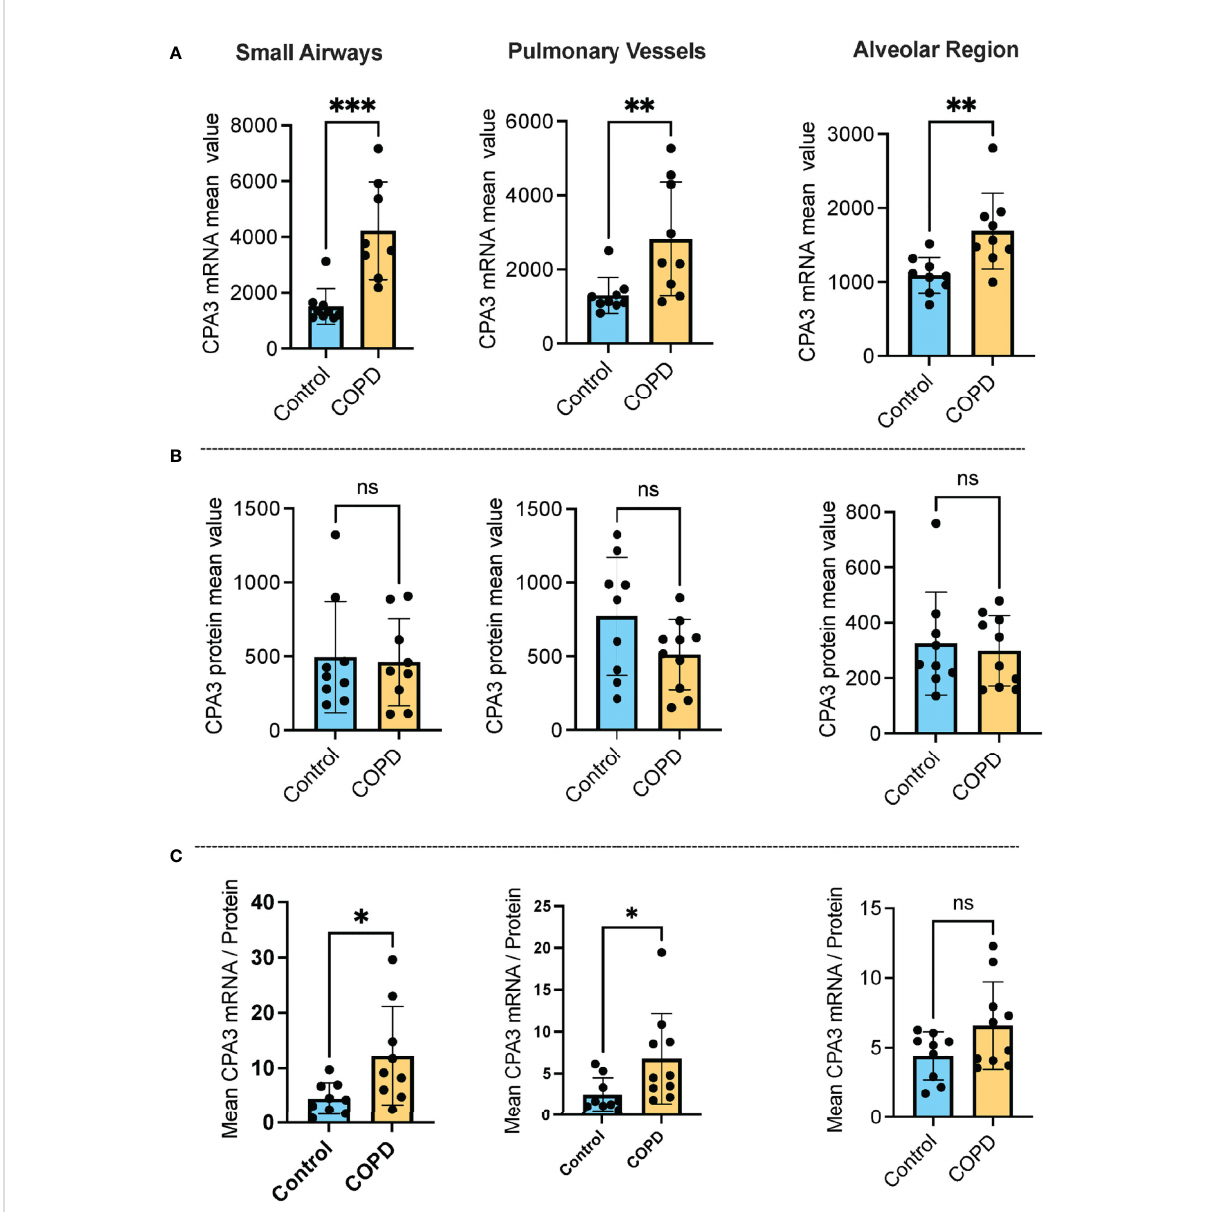
FIGURE 1 Increased mast cell CPA3 mRNA expression across major lung compartments in COPD lungs. (A – C) Mean patient values for individual mast cell expression of CPA3 mRNA (A) , CPA3 protein (B) , and the mean mRNA/protein quotient (C) in control subjects and COPD category GOLD 4 patients. In total, >18,000 individual mast cells were analyzed in the control group and >41,000 mast cells were analyzed in the COPD group. Dots denote mean patient values of >1,500 individual mast cells per control tissue and >2,500 mast cells per COPD patient. Statistical signi fi cance levels are marked as ns = non-signi fi cant, * p < 0.05, ** p < 0.01, and *** p <